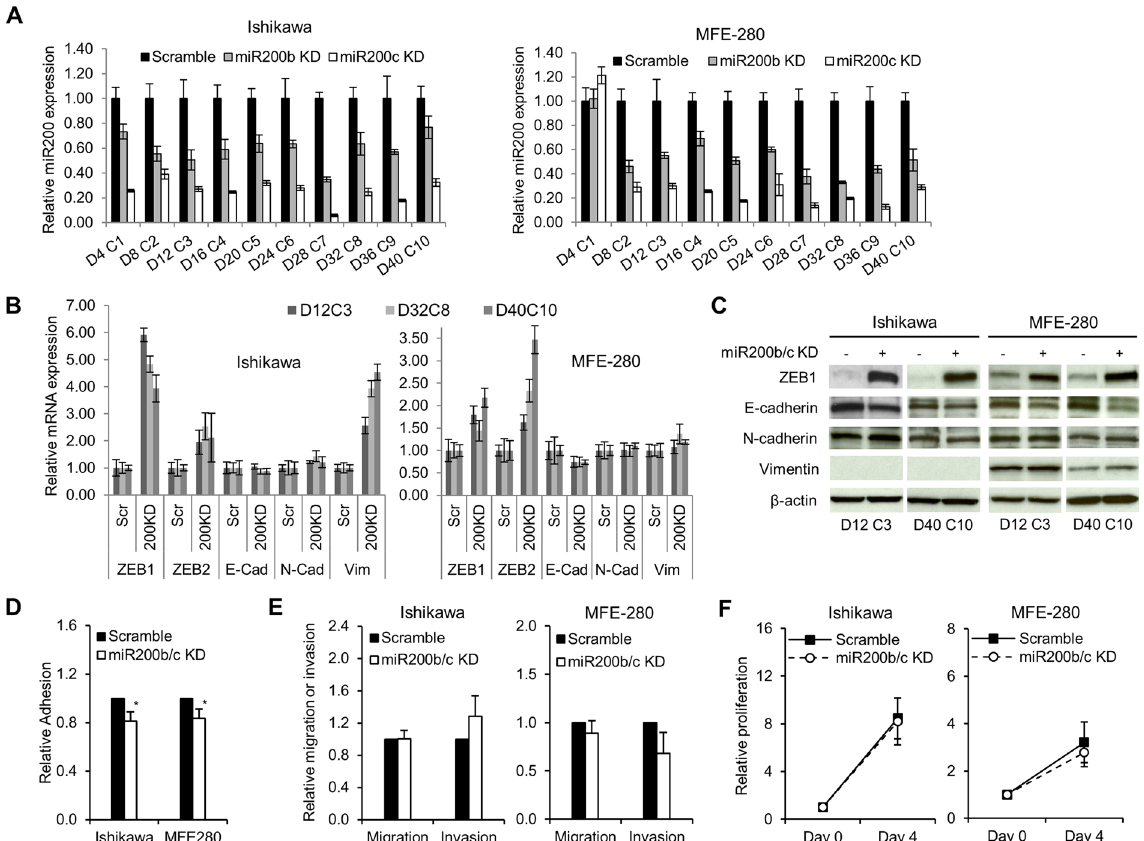
Figure 2. Effects of consecutive transient miR-200 depletion in EAC cell lines. ( A ) Constitutive miR-200b/c depletion in EAC cell lines. Ishikawa and MFE-280 cell lines were transiently transfected with miR-200b/c inhibitor every 4 days for a total of 40 days (D = day, C = transfection cycle). Bar graphs represent relative miR- 200b/c expression. Data are normalized to scramble. ( B ) Relative mRNA expression of EMT markers. TaqMan probes for ZEB1, ZEB2, E-cadherin (E-cad), N-cadherin (N-cad) and vimentin (vim) are shown on the bottom. Scramble (Scr) represents control for miR200b/c KD (200KD) samples. Data are normalized to scramble. Representative time points D12C3, D38C8 and D40C10 are shown. ( C ) Protein expression of EMT markers by immunoblotting. Representative early and late time points are shown. Anti- β -actin serves as a loading control. ( D ) Relative adhesion, and ( E ) migration and invasion in miR-200b/c knockdown (miR200b/c KD) vs. scramble-treated cells. ( F ) Relative proliferation measured by cell counts. Data are normalized to Day 0. All graphical data are reported as mean ± SD. * P < 0.05; paired sample t-test. There were no statistically significant differences in migration, invasion or proliferation between miR-200b/c knockdown and scramble-treated